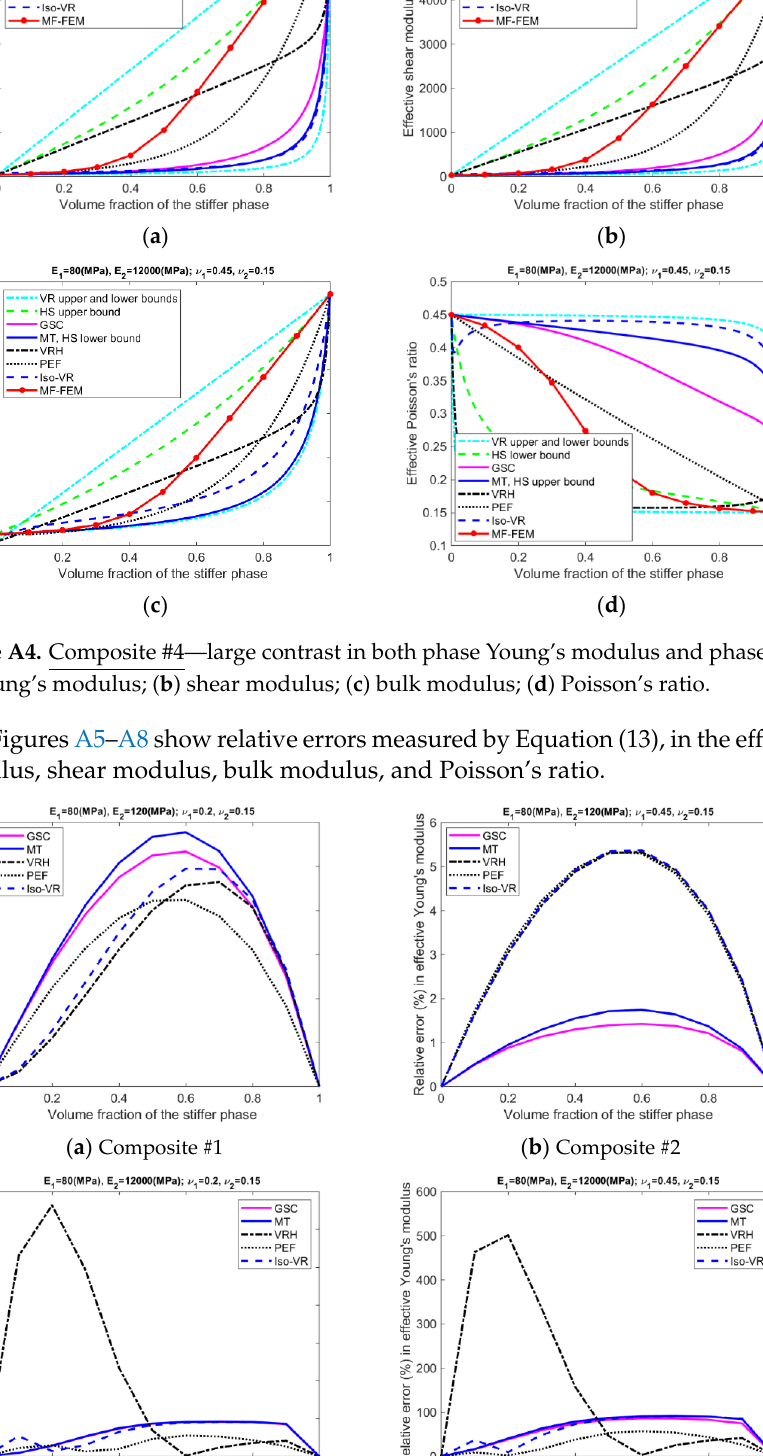
Figure A5. Relative error in effective Young’s modulus.